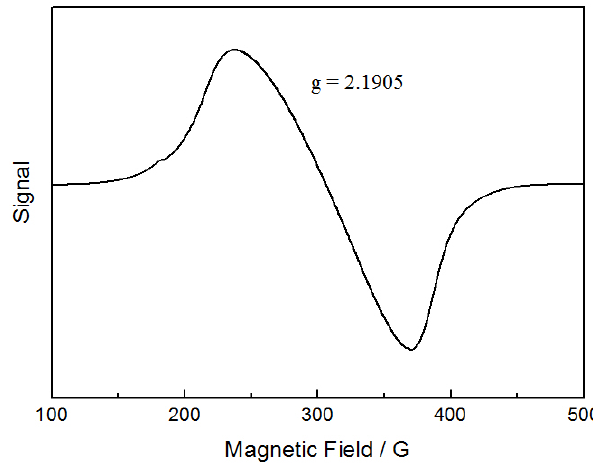
Figure 5. Electron paramagnetic resonance (EPR) spectra of Fe 9 TiO 15 @TiO 2.